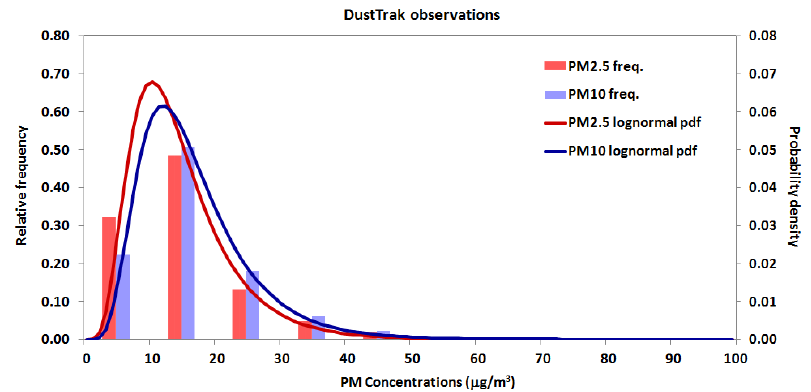
Figure 5. Frequency distribution and corresponding probability density function of PM 2.5 and PM 10 concentrations measured by the DustTrak reference instrumentation during sensors calibration.